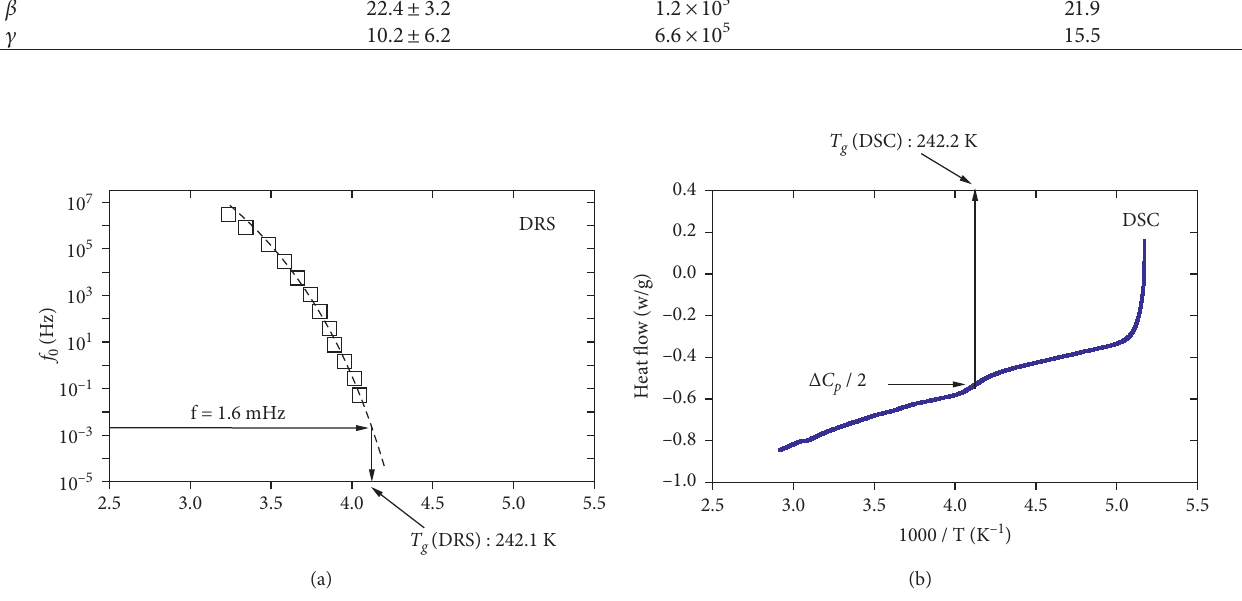
Figure 9: (a) the glass transition temperature determined by DRS and (b) the glass transition temperature determined by DSC. Table 5: The dipole moment calculated for a specific monomer in NBR.